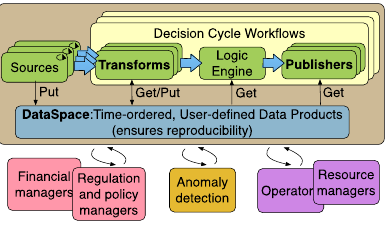
Fig. 2. The Decision Engine top-level components. Fig. 3. Key elements on the design.